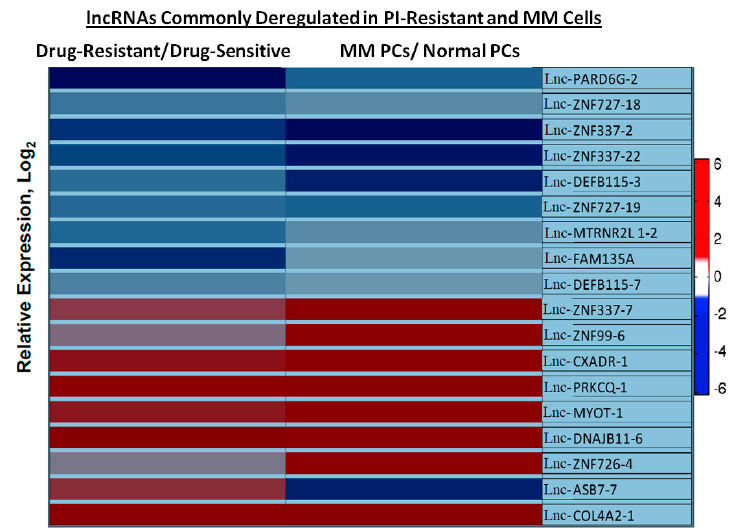
Figure 5. Comparison of lncRNAs deregulated in both drug ‐ resistant cells relative to drug ‐ sensitive cells and MM patient plasma cells (PC) relative to healthy plasma cells. lncRNAs commonly deregulated between the three PI ‐ resistant cell lines with drug ‐ sensitive parental RPMI8226 cells and in MM patient CD138+ cells relative to healthy CD138 + cells.